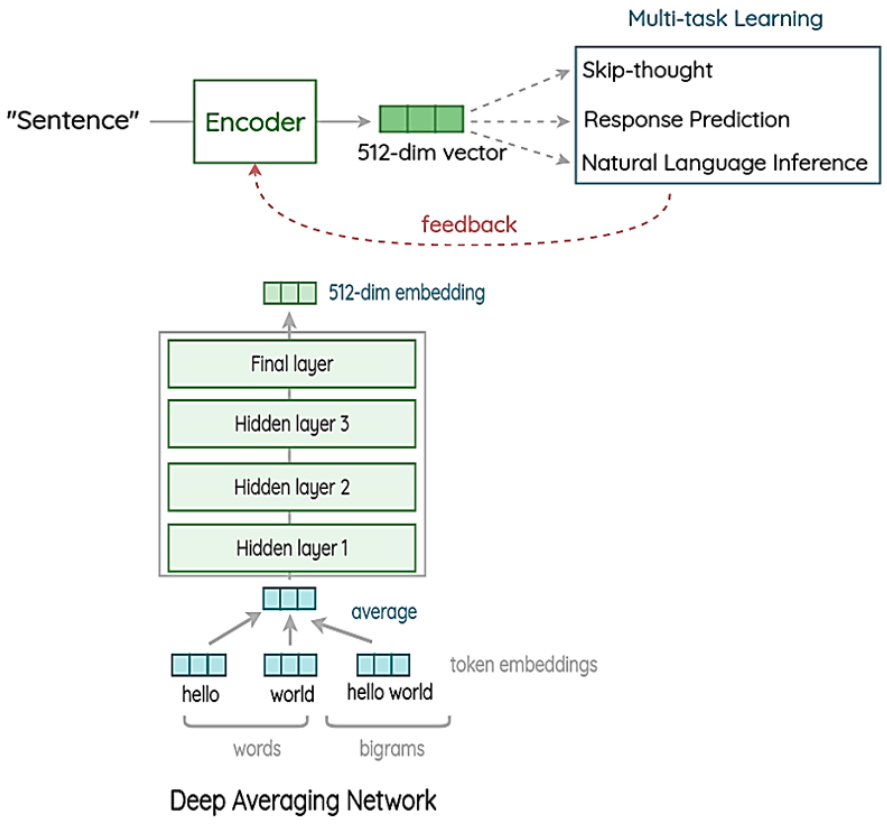
Figure 7. Universal sentence encoder multi-task and deep averaging network [48].